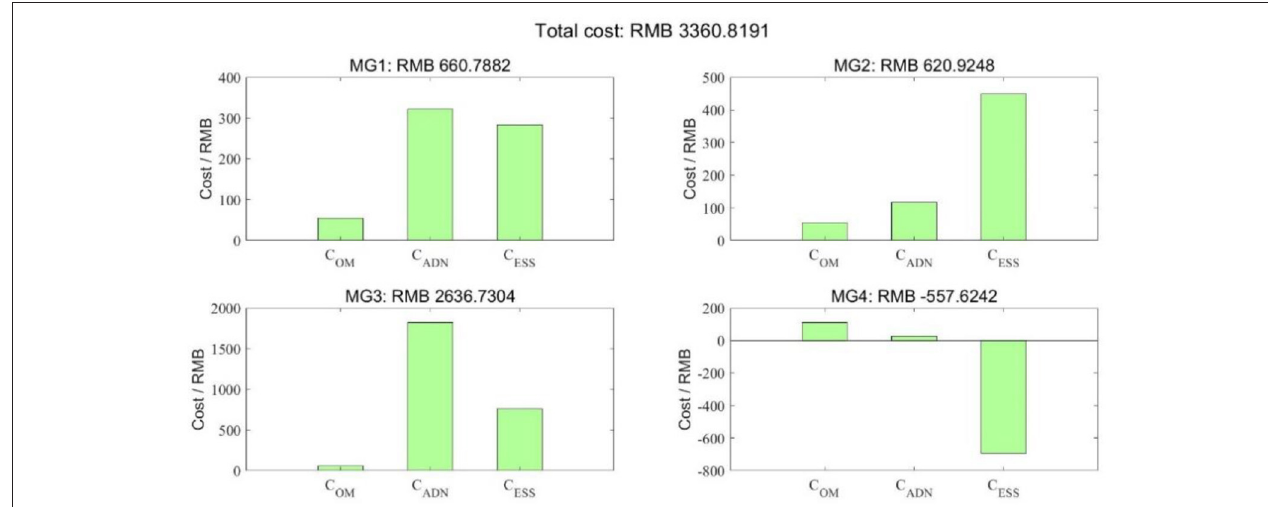
FIGURE 5 | The energy bills of each microgrid within the cluster in scenario 1.